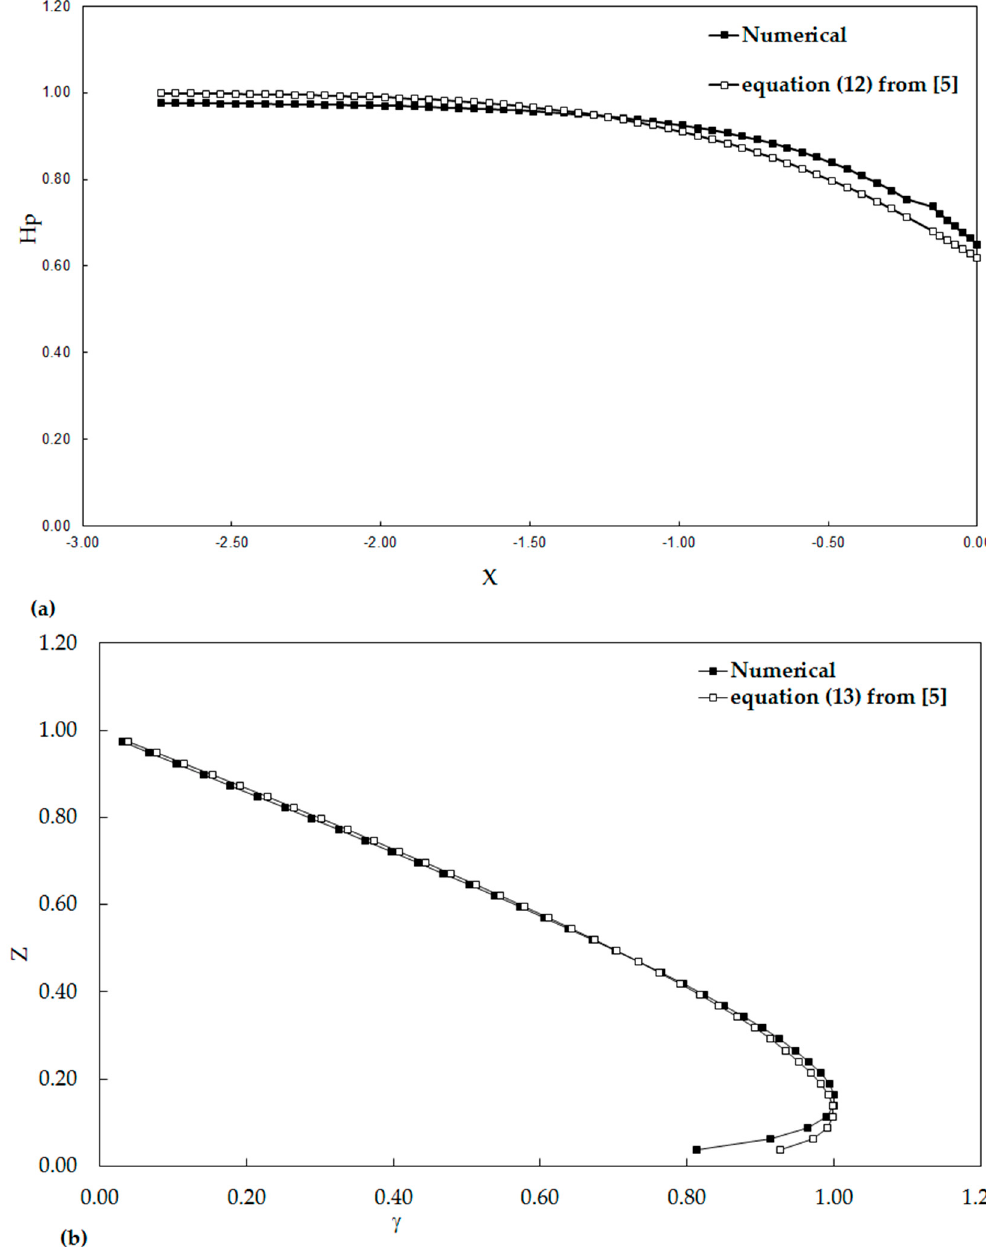
Figure 10. ( a ) Bottom pressure distribution comparison with Equation (12) given by [5] and ( b ) gate pressure distribution comparison with the Equation (13) given by [5].